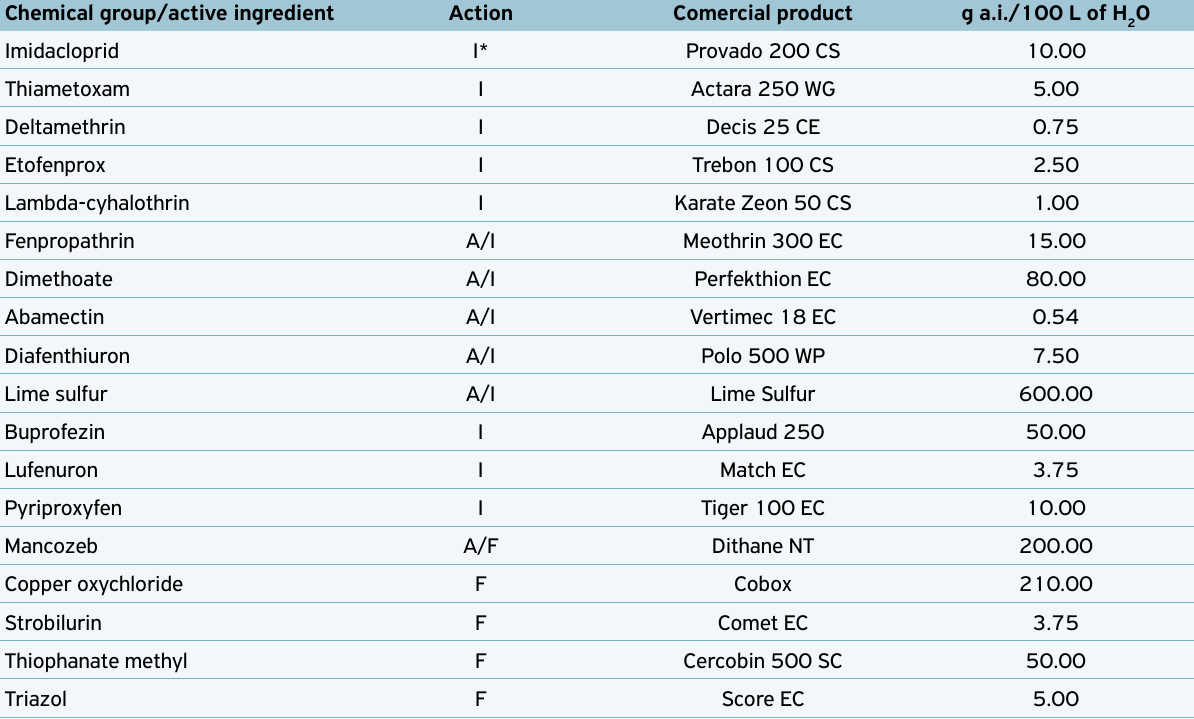
Table 1. Pesticides and their highest recommended rate for pest or disease control in Brazilian citrus. Chemical group/active ingredient